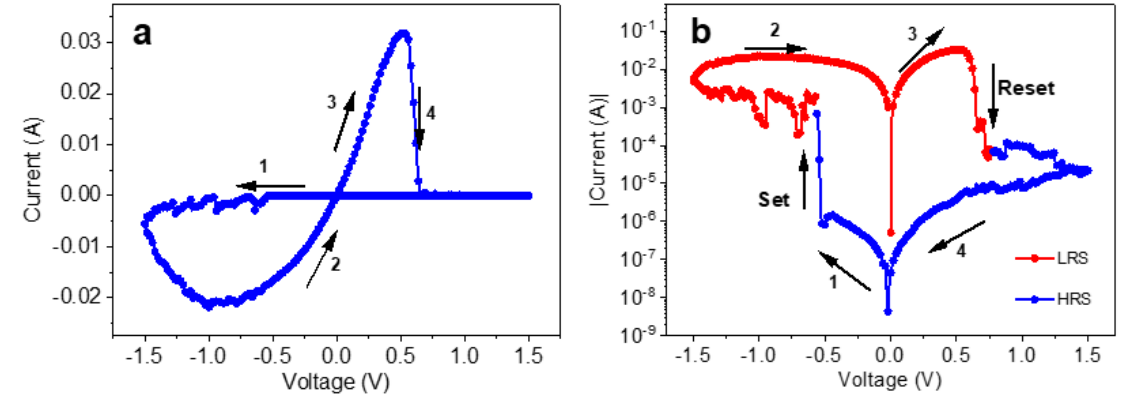
Figure 5. ( a ) I–V curve for the Au/PB/Ag layer stack showing the resistive switching effect. ( b ) Logarithmic plot of absolute current overvoltage. The red and blue part of the curve shows the LRS and HRS regimes, respectively.